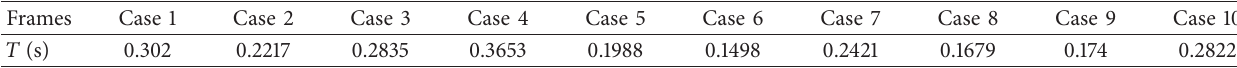
Figure 3: Models of the frames corresponding to the cases 1, 2, 3, 4, 5, 6, 7, 8, 9, and 10. Table 1: Natural periods of the ten